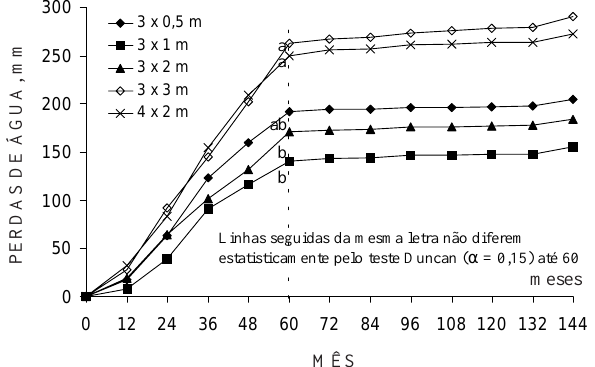
Figura 1. Perdas acumuladas de água em Argissolo Vermelho-Amarelo eutrófico de Pindorama (SP), com a cultura de café, de julho de 1960 a junho de 1972. Precipitação total: 14.462